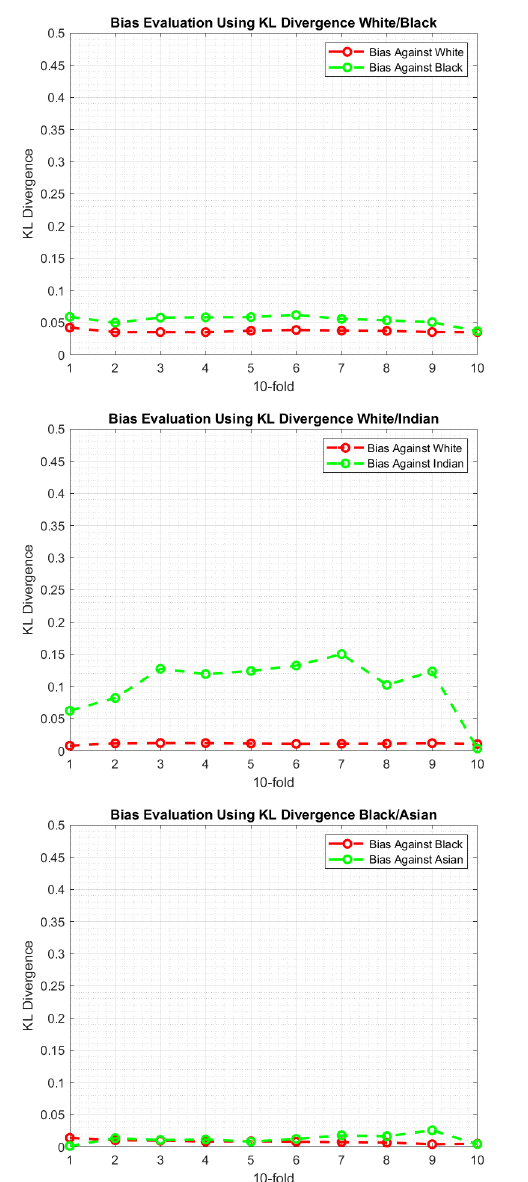
Figure 6. Bias in wages in terms of Race2.